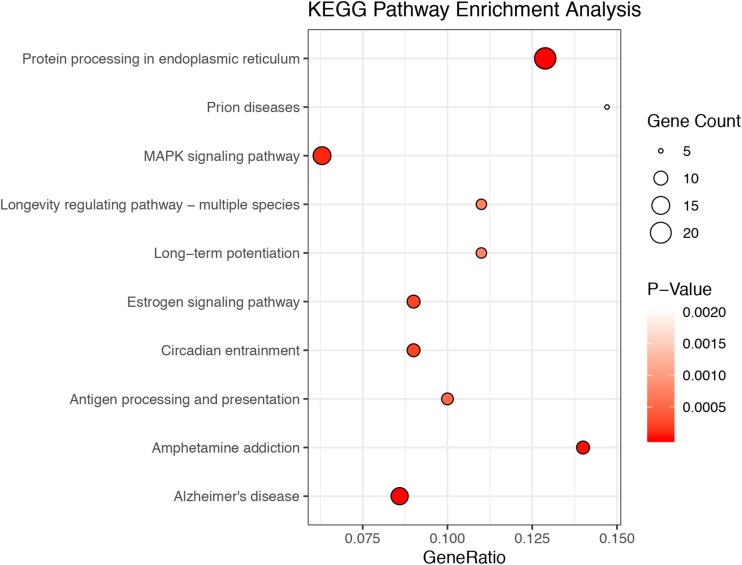
The top 10 enriched KEGG pathways among DEGs. The 354 DEGs belong to 39 KEGG pathways. The figures depict the number of DEGs in the top 10 most enriched pathways, with the size of the circles related to the number of genes in each pathway.